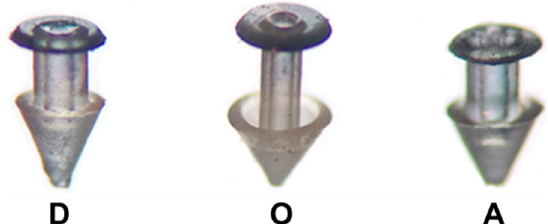
Figure 1. Morphology of occluders. The three types of occluders used in the study were: Delta R (D), Odyssey R (O) and Alphamed R (A). The top diameter of the three occluders was 0.9 mm and their length ~2 mm.